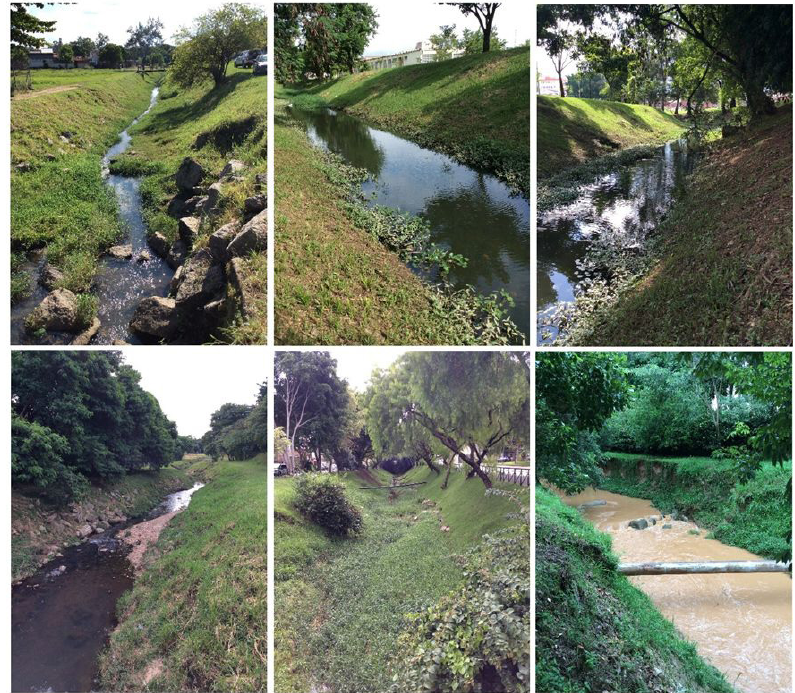
Figure 2. Representative stream stretches sampled from Sorocaba